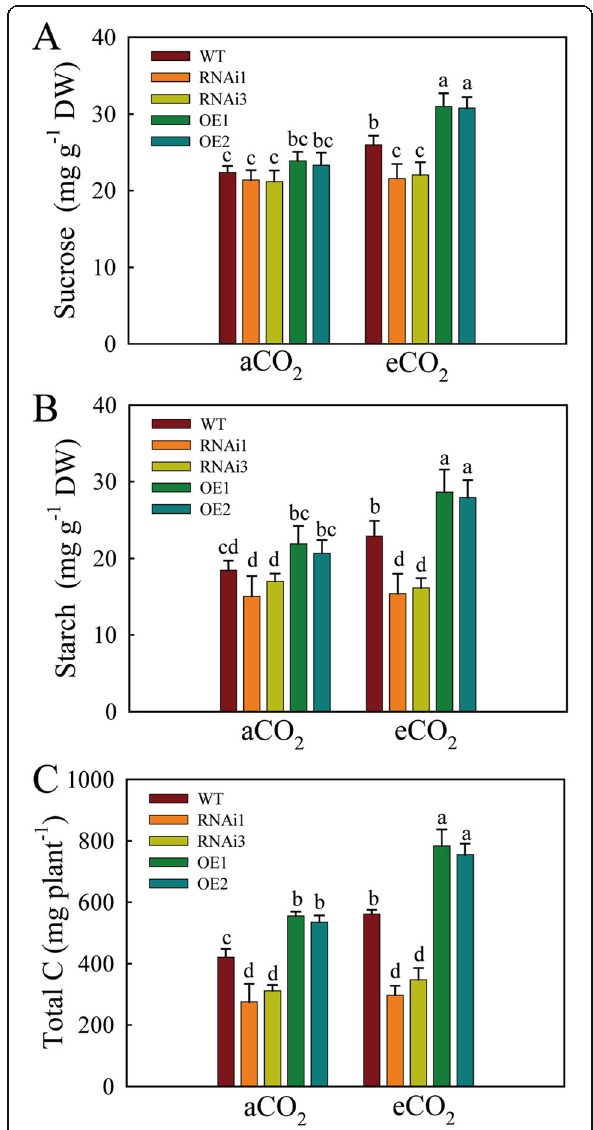
Fig. 5 Effects of eCO 2 on the contents of carbohydrates in WT, RNAi lines and OE lines of qPE9-1 . ( A ) Sucrose ( n = 5). ( B ) Starch ( n = 5). ( C ) Total C ( n = 5). All values are means ± SD; different letters indicate significant differences ( P <